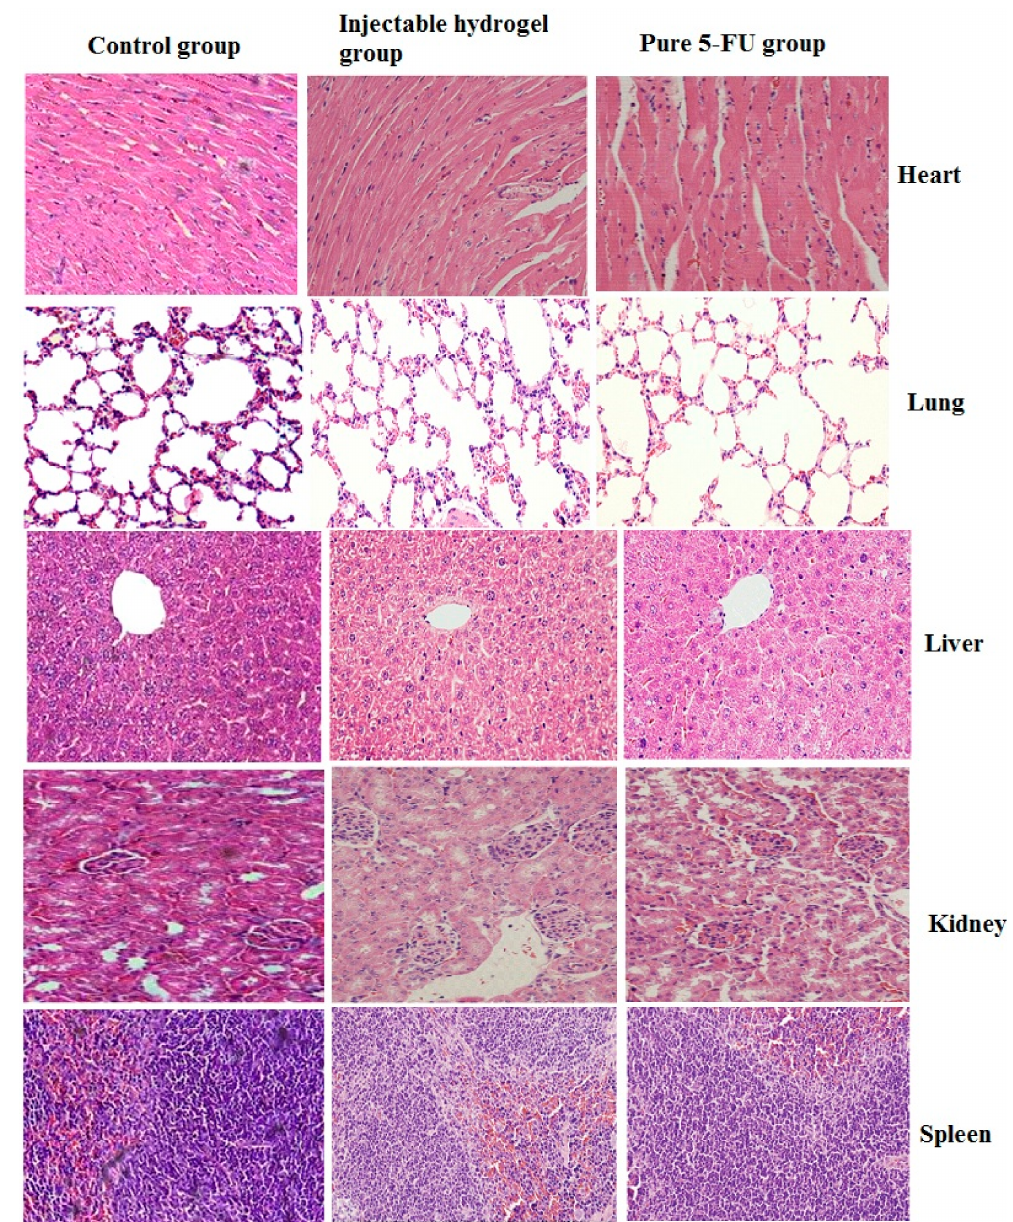
Figure 15. Histopathological micrographs of different rabbit organs of control, pure free 5-FU treated, and 5-FU loaded injectable gel groups after the subcutaneous